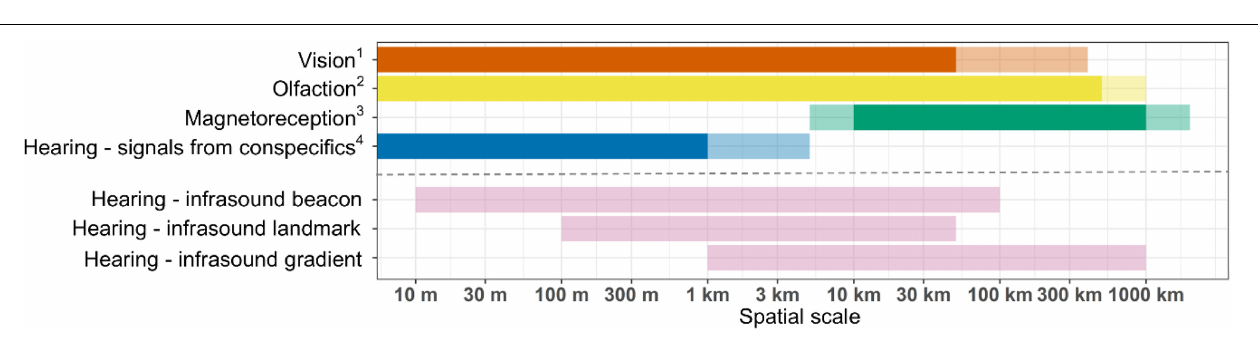
FIGURE 5 | The predominant sensory modalities used by seabirds and the hypothesised spatial scales over which they operate (above dotted line) as well as the hypothesised scales over which infrasound hypotheses are proposed to provide information (below dotted line). The known range at which animals may be using each sensory modality is based on the literature and highlighted by a bright colour, while the probable or hypothesised range is shown by a faded colour. Each infrasound hypothesis is provided separately, shown in faded pink. Note that for several senses (e.g., vision, olfaction) the hypothesised scales incorporate the ranges at which animals have been proposed to use learned map-like information. The spatial scale is presented on a log10 scale and ranges from 0 m to 2,000 km. 1 Collet et al. (2015), Pollonara et al. (2015), and Padget et al. (2017). 2 Nevitt (2008), Nevitt et al. (2008), and Reynolds et al. (2015). 3 Wynn et